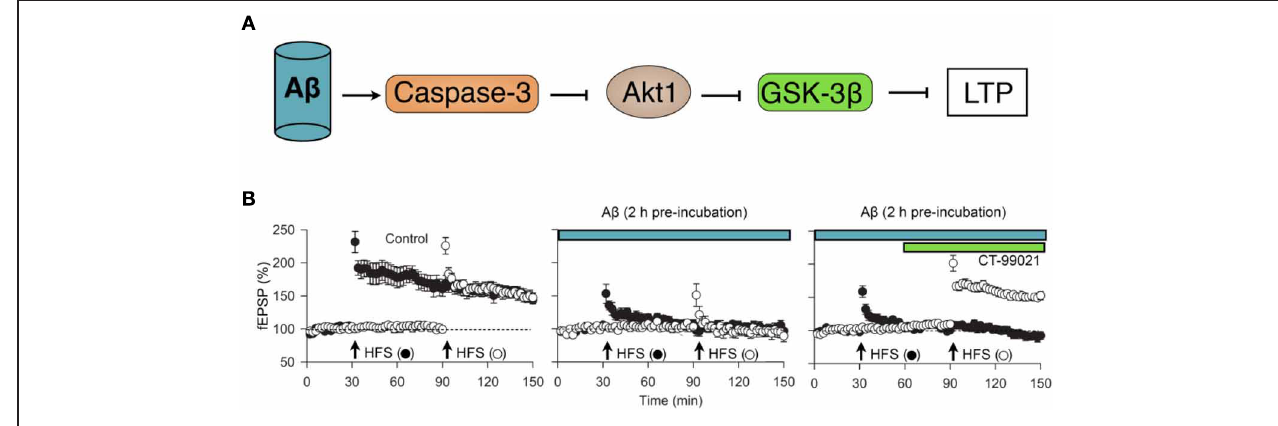
FIGURE 5 | The CAG cascade. (A) potential mechanism by which various neuronal insults (exemplified here by A β 1–42) may inhibit NMDAR-LTD via the activation of caspase-3 (C) which, by resulting in cleavage of Akt (A), results in persistent activation of GSK-3 β (G). (B) Experimental data in support of the “CAG” cascade hypothesis. Pooled data (from